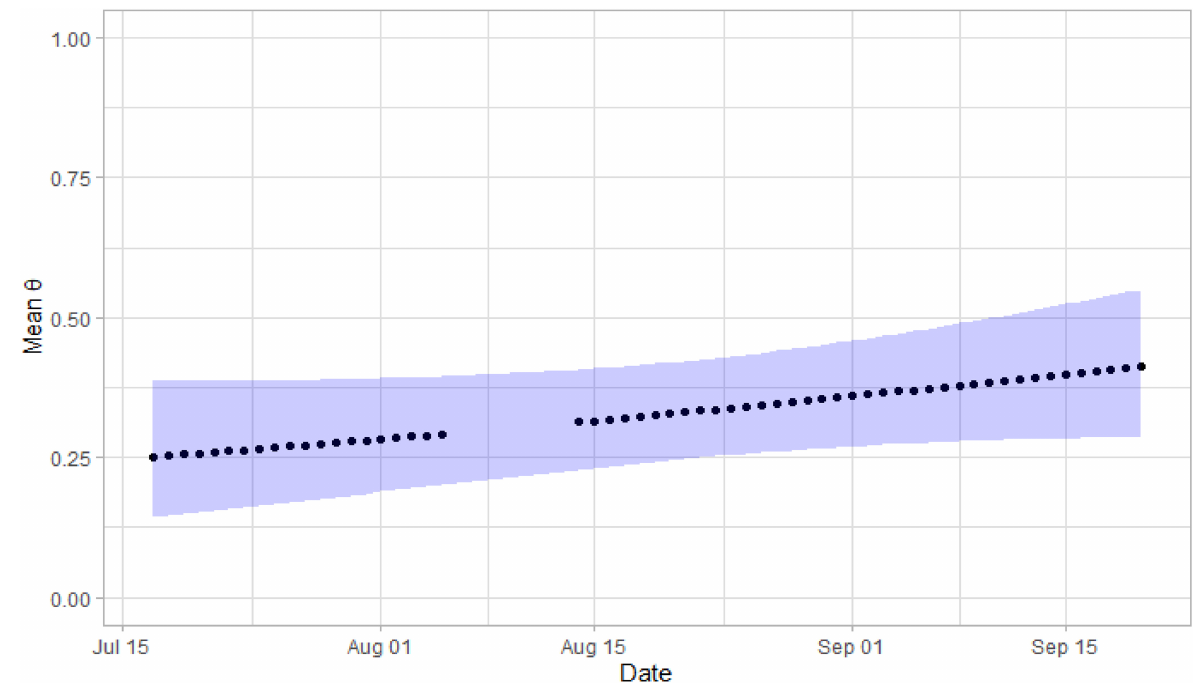
Frontiers in Ecology and Evolution |